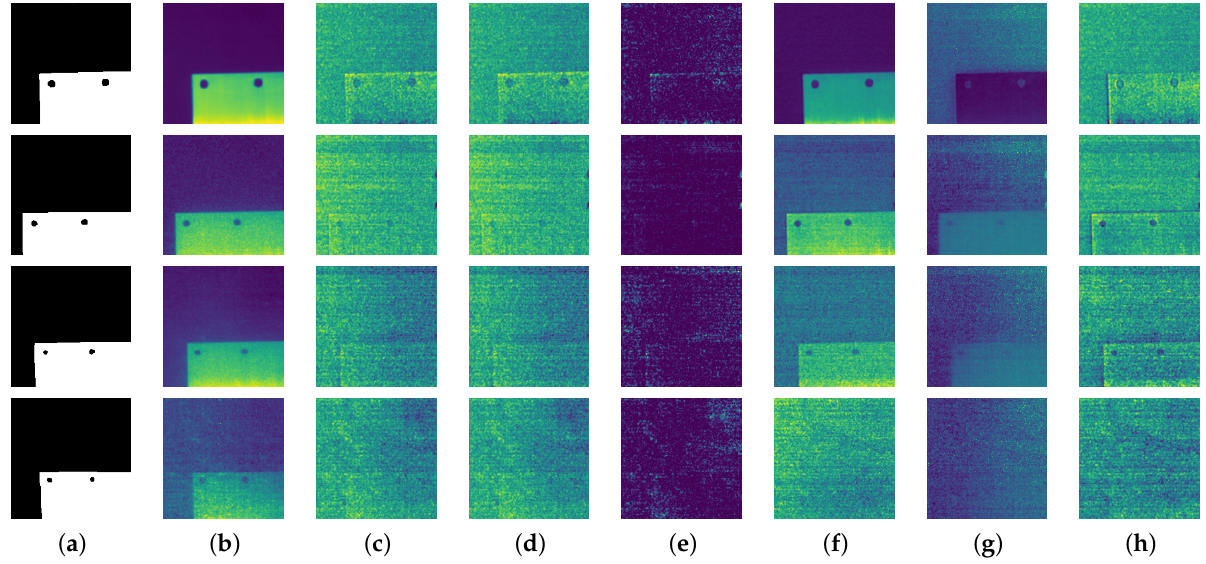
Figure 16. ( a ) Ground truth of the 0.1, 0.5, 1.0, 1.6 m submerged iron plate. ( b ) TUTDF. ( c ) MF. ( d ) CEM. ( e ) ACE. ( f ) OSP. ( g ) SAM. ( h )